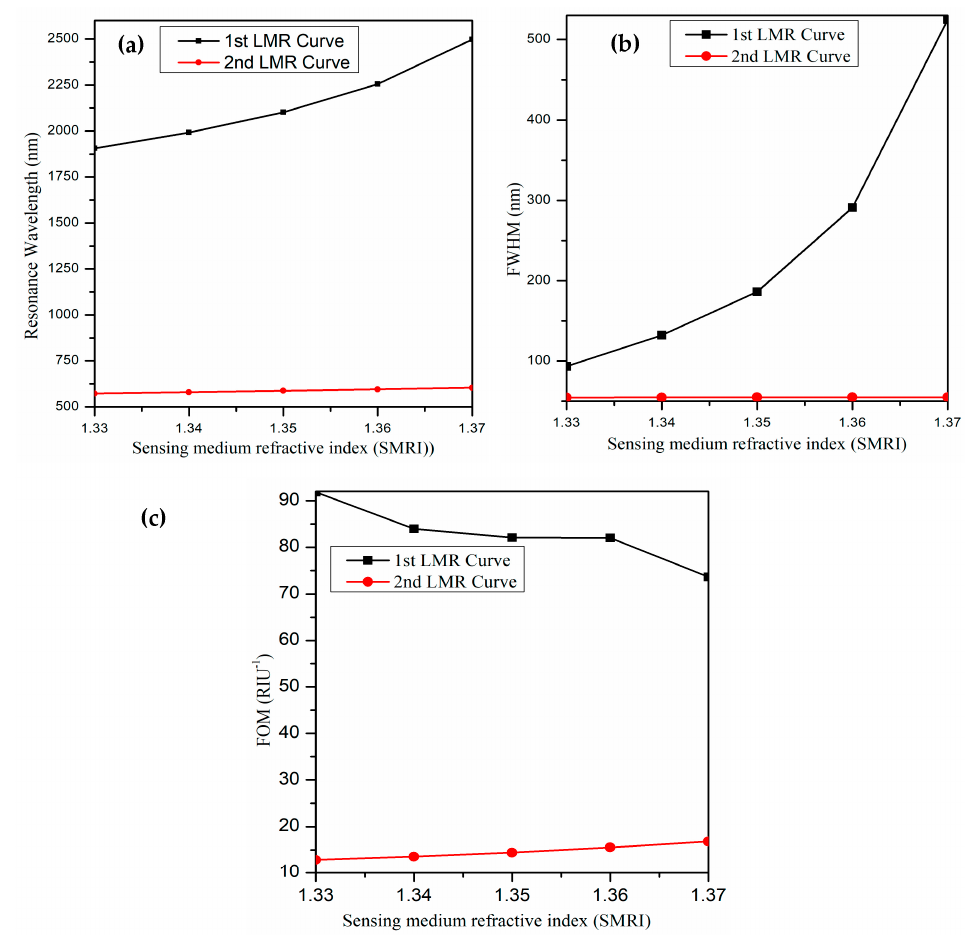
Figure 4. Variation in ( a ) resonance wavelength, ( b ) FWHM, and ( c ) FOM with sensing medium refractive index of both LMRs for the proposed U-shaped LMR sensor.